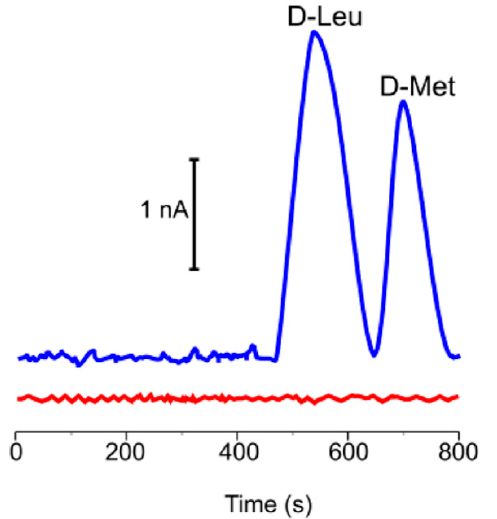
Figure 3. Microchip electropherograms of DAAO (0.5 mg/mL) reaction with a mixture of D-Leu and D-Met (blue line) and L-Leu and L-Met (red line). This figure is reprinted with permission from https://pubs.acs.org/doi/10.1021/acs.analchem.5b00979 [67]. Further permissions related to the material excerpted should be directed to the ACS.